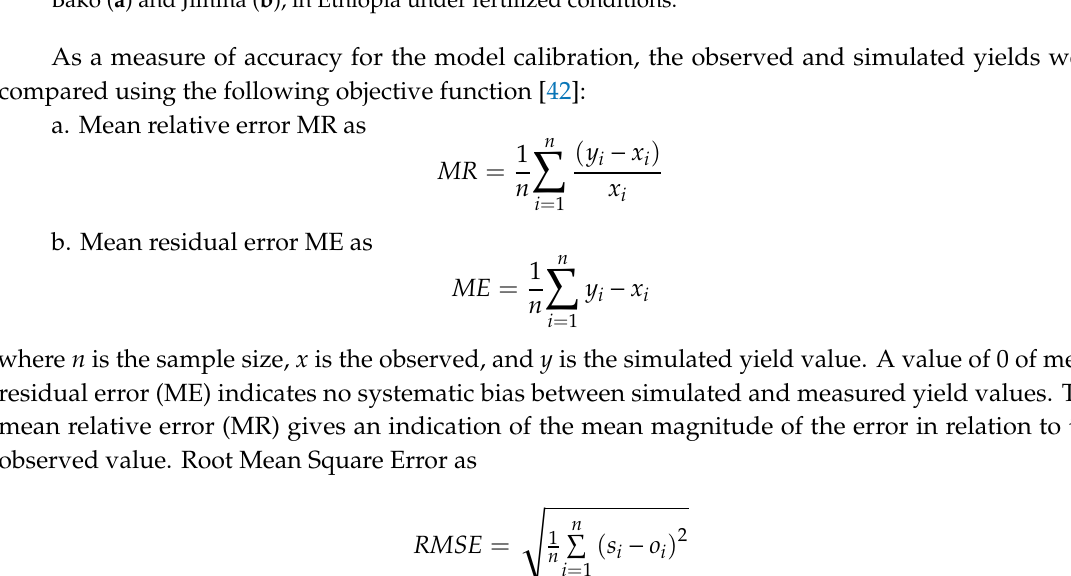
Figure 2. Observed and simulated maize yield (variety BH660) in (Mg/ha ) at two experimental sites, Bako ( a ) and Jimma ( b ), in Ethiopia under fertilized conditions.